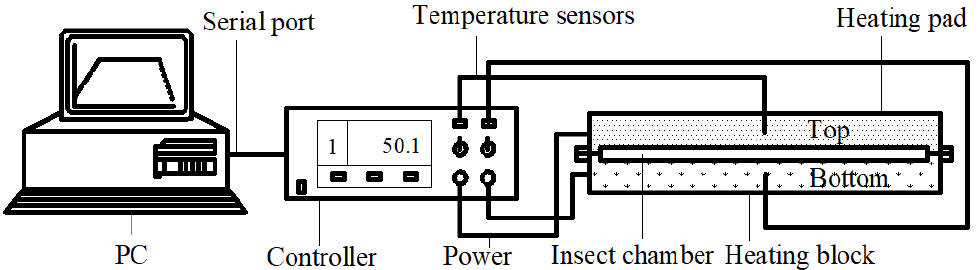
Figure 1. Schematic diagram of heating block system for insect mortality experiments [22].